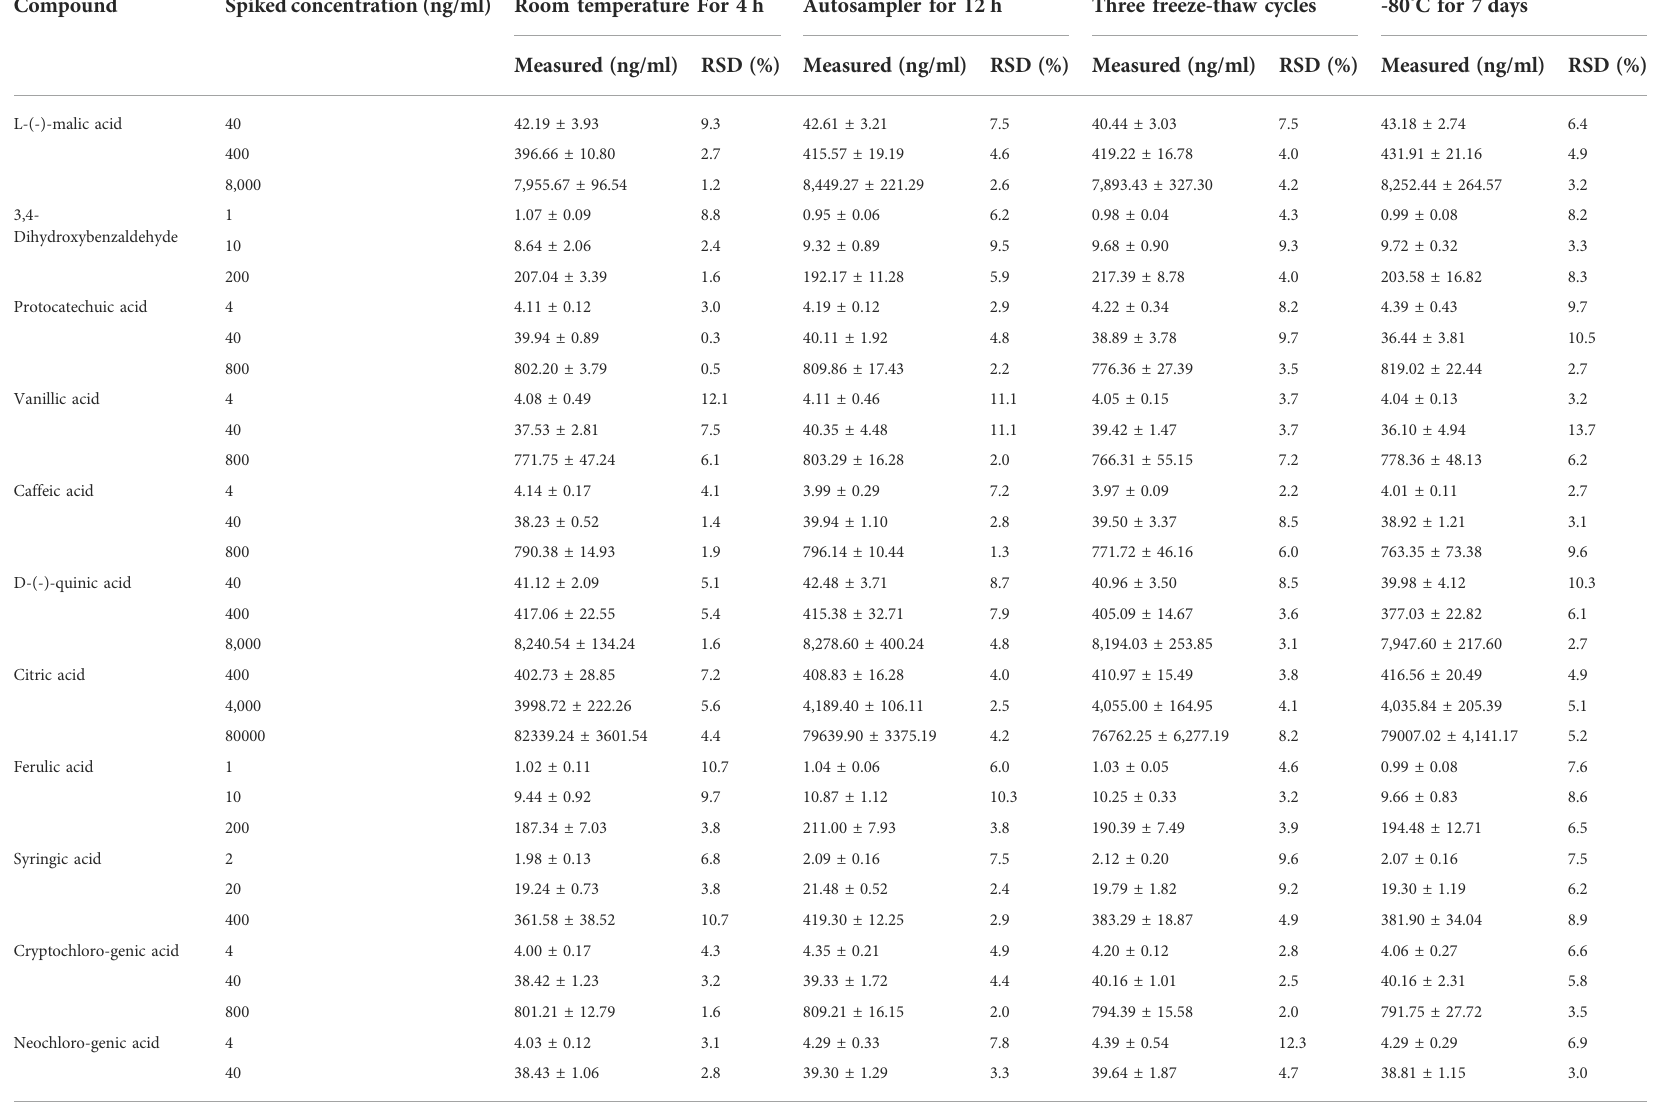
TABLE 4 Stability of 16 analytes in rat plasma ( n = 6).